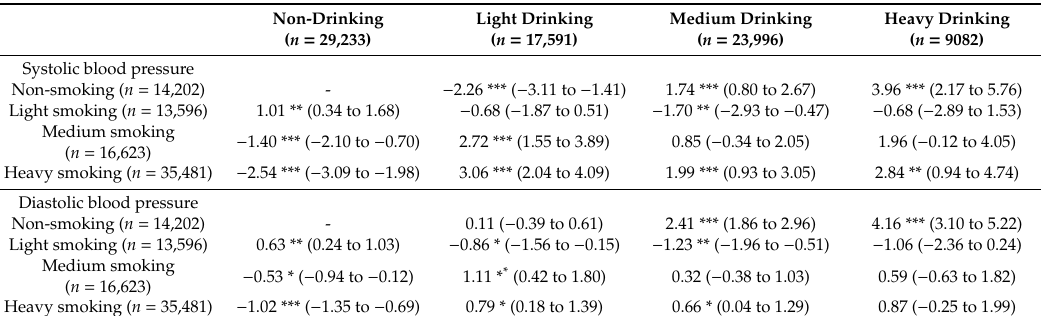
Table 6. Multivariable a linear regression coe ffi cients (95% confidence interval) for systolic and diastolic blood pressure levels among male participants b according to di ff erent amounts of smoking and alcohol